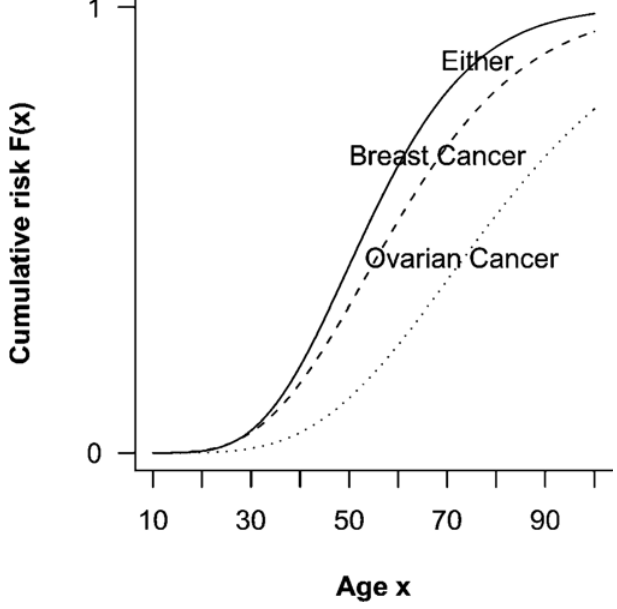
Figure 1. Age-specific risk of developing the disease. Women’s cumulative risk of developing breast cancer (dashed line, F b ( x )), ovarian cancer (dotted line, F o ( x )) or either (solid line, F bo ( x )) in a population free of any other causes of death. The two functions F b ( x ) and F o ( x ) are fitted 2-parameter cumulative gamma distributions from data from [9]. For breast cancer, F b ( x ), a =7.93 and b =7.54; and for ovarian cancer, F o ( x ), a =8.20 and b =9.86. The cumulative gamma function associated with this risk F bo ( x ) has parameters a =9.97 and b